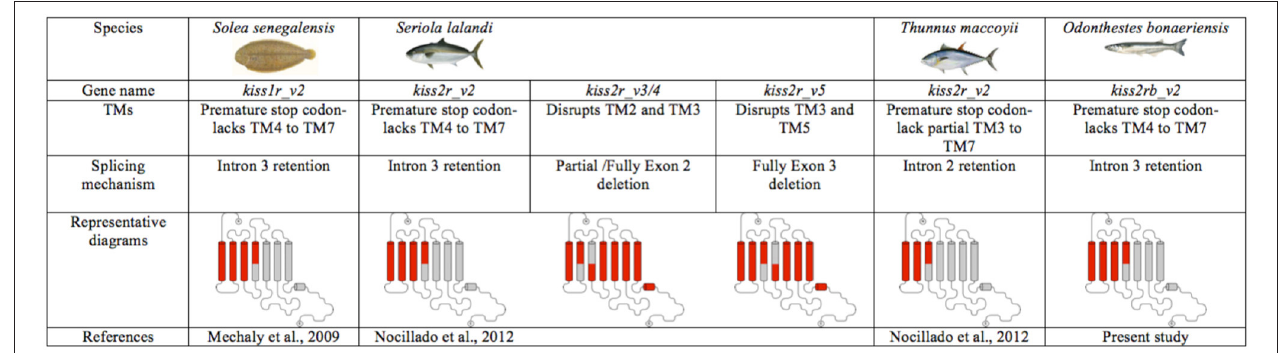
FIGURE 7 | Different mechanisms of alternative splicing present in the kissr2 gene of teleost fish due to intron retention and transmembrane domain (TM) deletion in kissr2 .